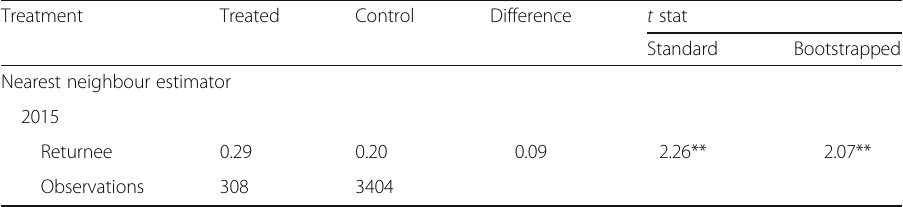
Table 8 Average treatment effect of the treated: likelihood of finishing primary school Treatment Treated Control Difference